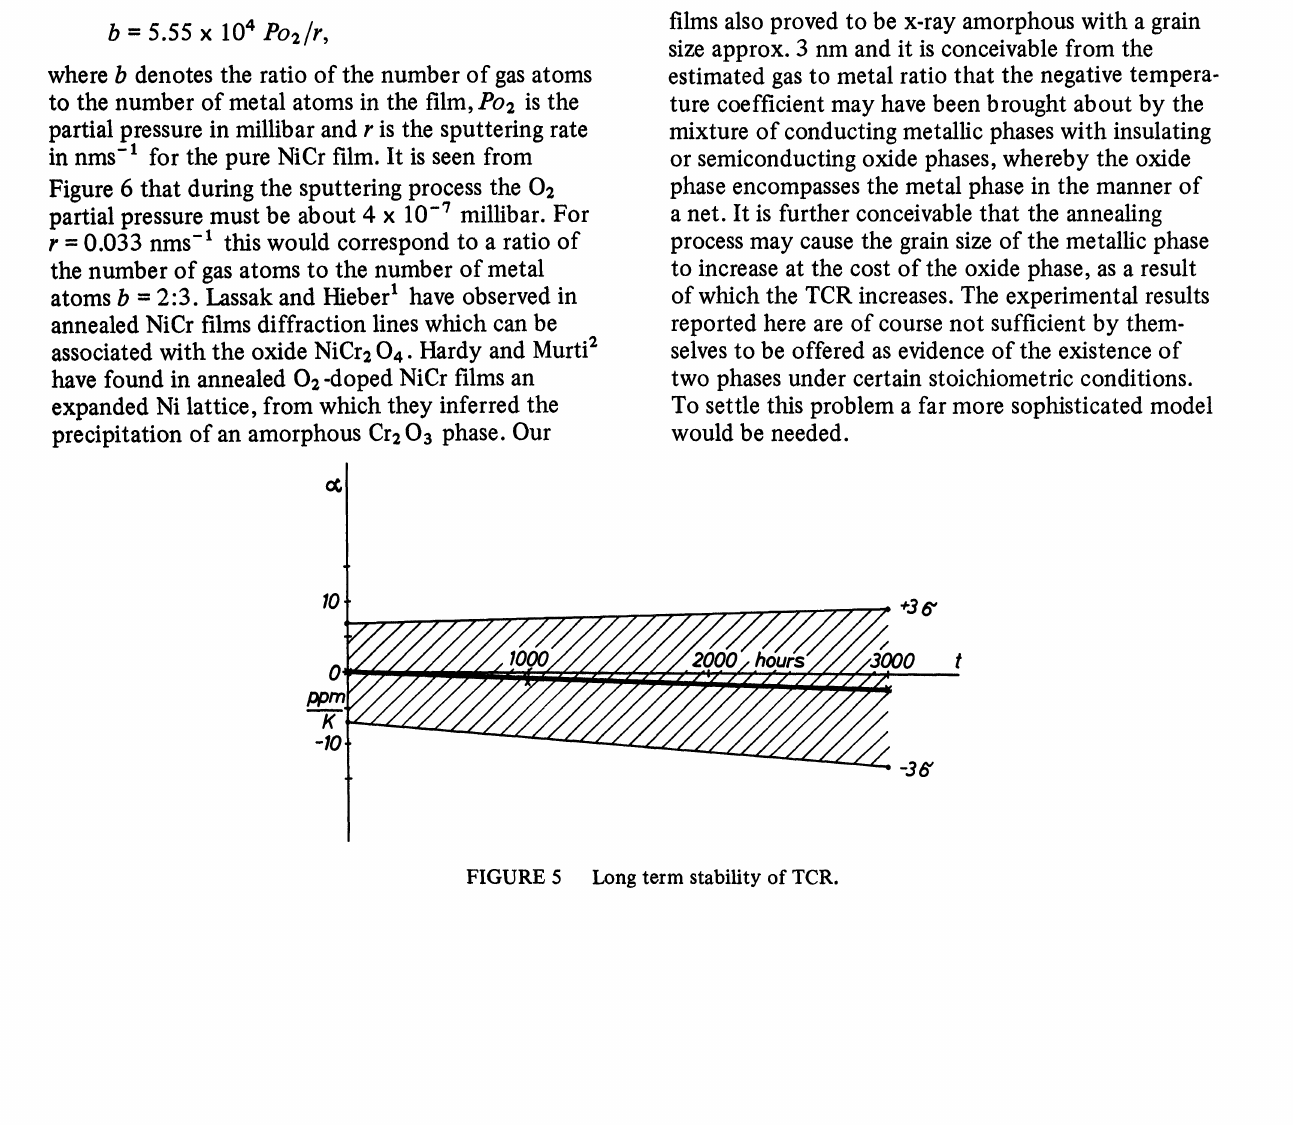
FIGURE 5 Long term stability of